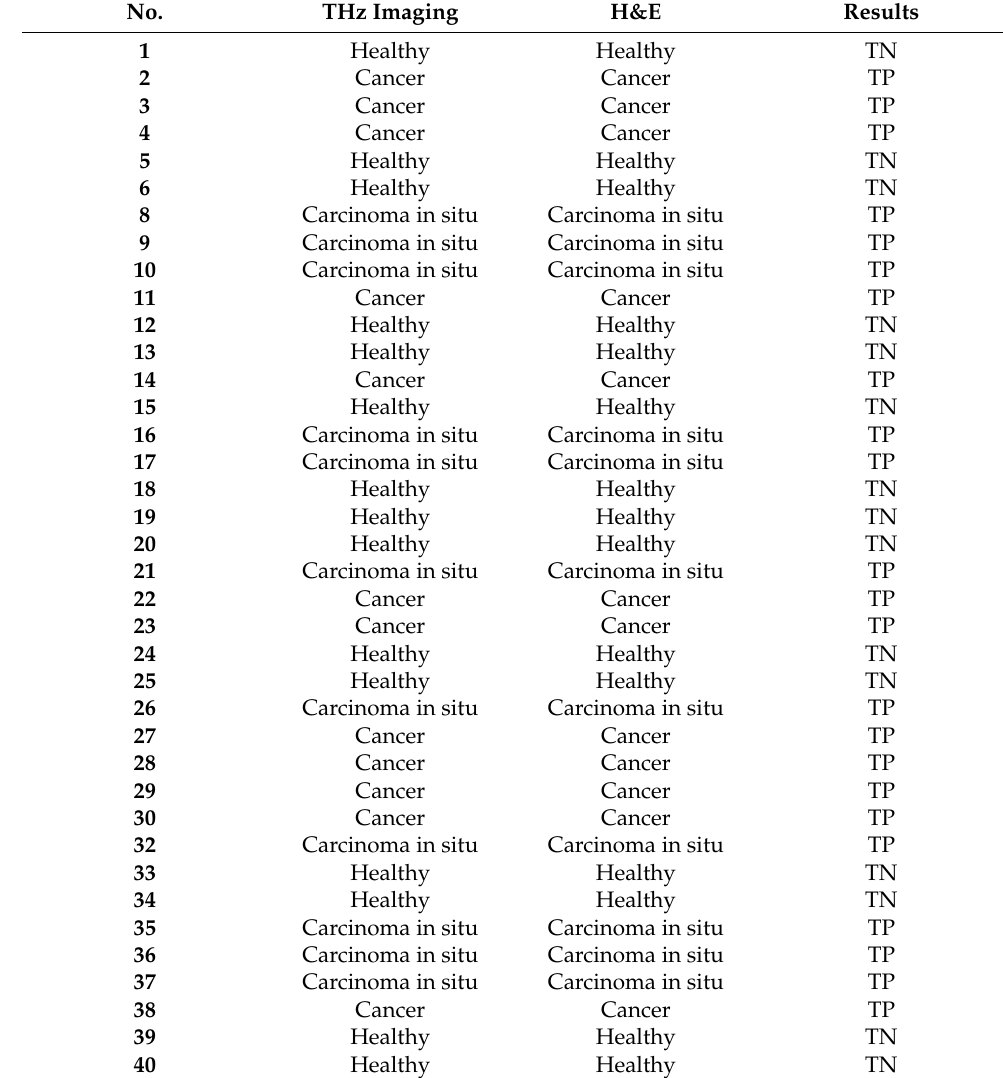
Table 1. Diagnostic results via the THz imaging and H&E staining methods.